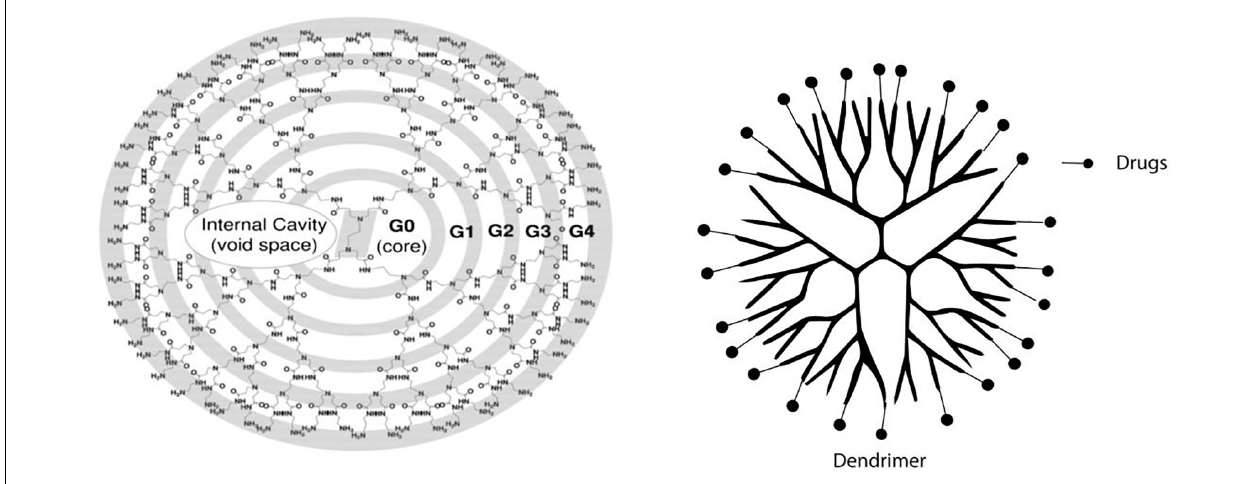
FIGURE 6 | Schematic representation of dendrimer. PAMAM-NH2 G0 to G4 dendrimer starts from an ethylenediamine core; the branches or arms were attached by exhaustive Michael addition to methyl acrylate followed by exhaustive aminolysis of the resulting methyl ester using ethylene diamine. Reprinted with permission (Abbasi et al., 2014).